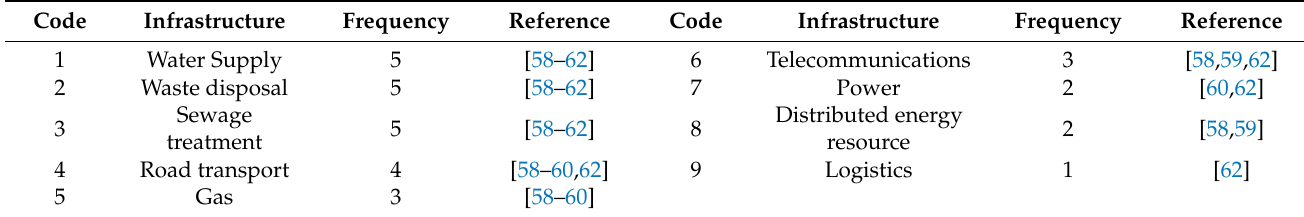
Table 3. Main types of infrastructure according to official documents.